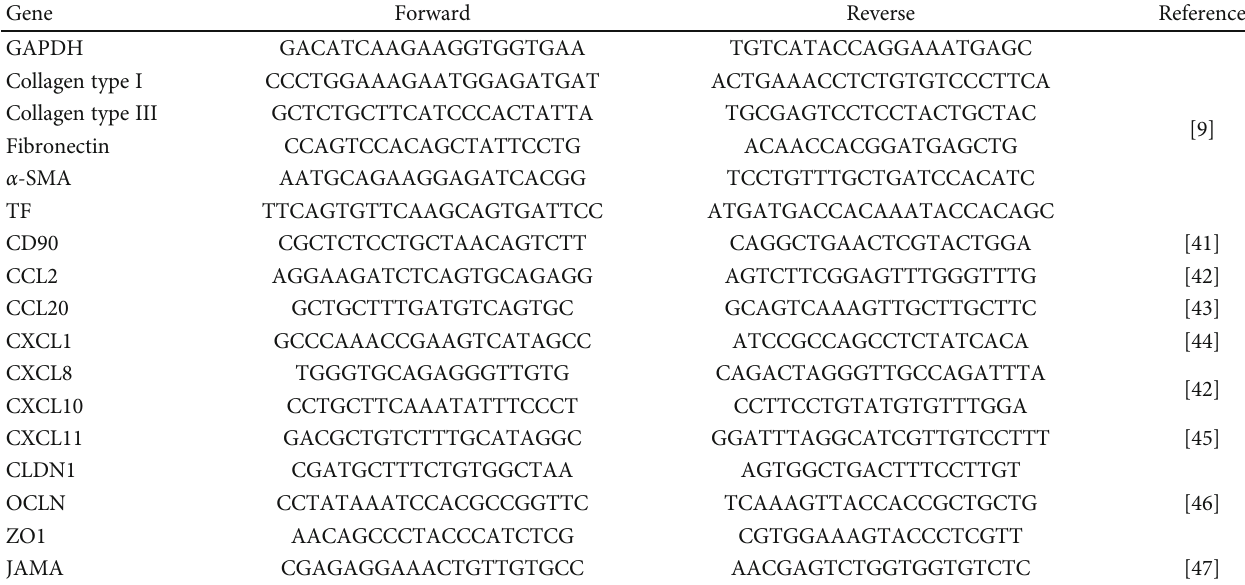
Table 1: Gene-speci fi c primers used in real-time